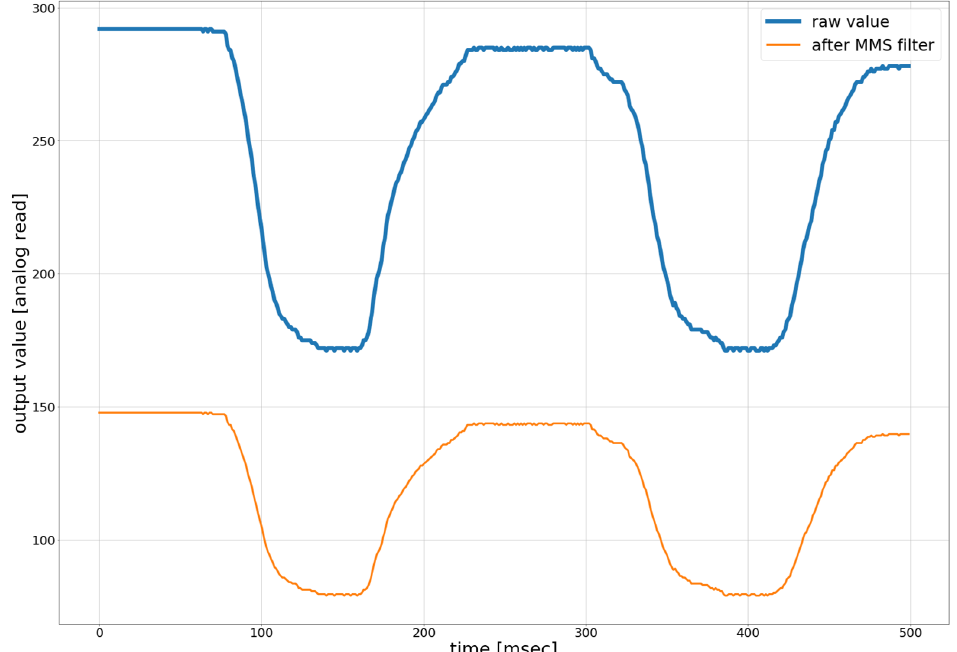
Figure 6. Raw and filtered values of the proposed calibration method with the MMS filter. The x-axis represents the time in microseconds and y-axis represent the analog output value from sensors before and after applying MMS filter.